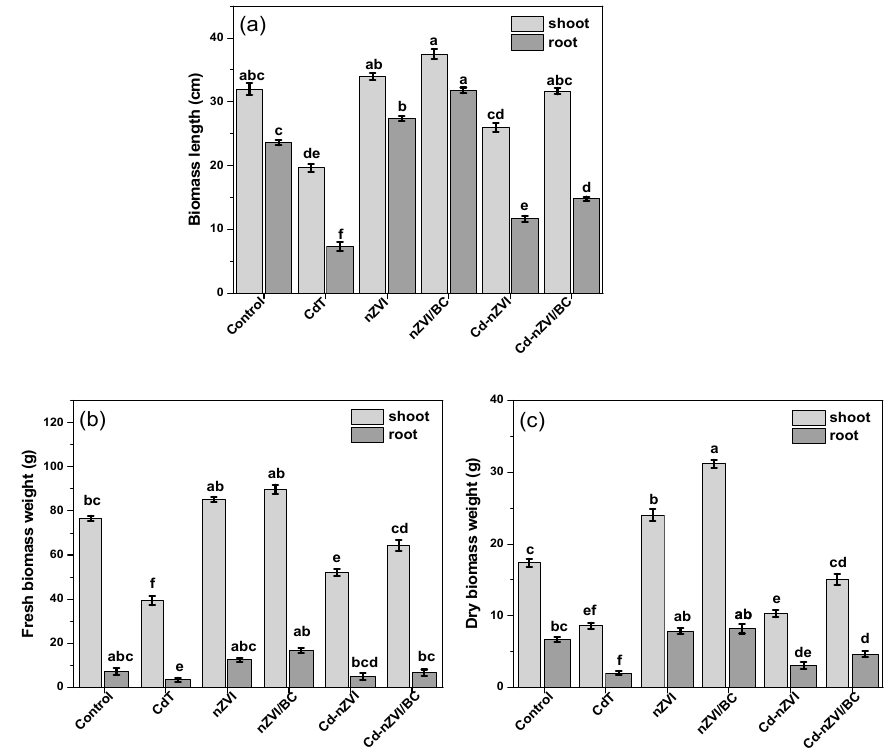
Figure 5. Impact of nZVI and nZVI/BC application on plant physiology in normal and Cd-polluted soils, ( a ) biomass length; ( b ) fresh biomass weight; ( c ) dry biomass weight. Bars not sharing the same lower-case letter are significantly different (Tukey’s HSD α < 0.05). Represented data are the means of three replications ( n = 6) with ± standard deviation.